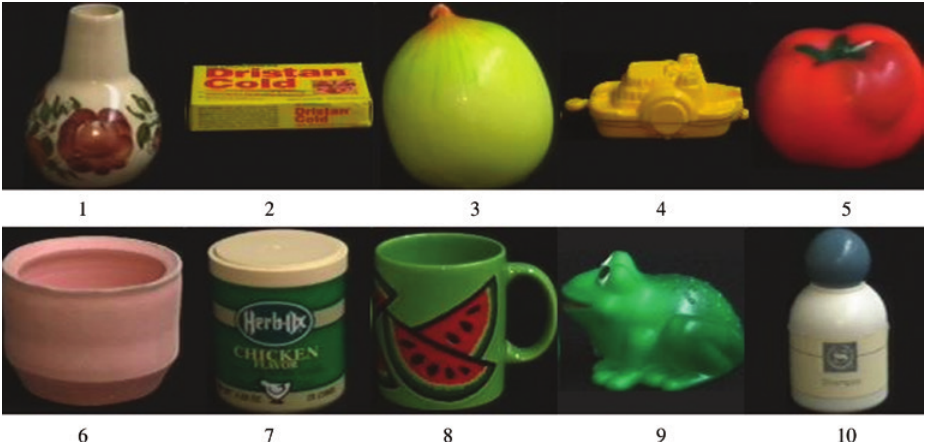
Figure 5: Ten Categories of Images Used for the